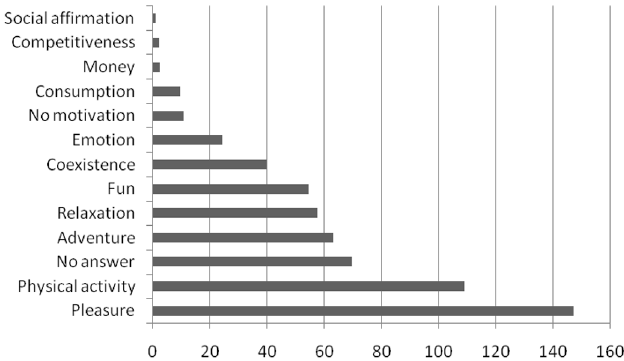
Fig. 3. Spear fi sher ’ s motivations. More than 140 spear fi shers indicated that “ pleasure ” was their main motivation (2004 survey, n